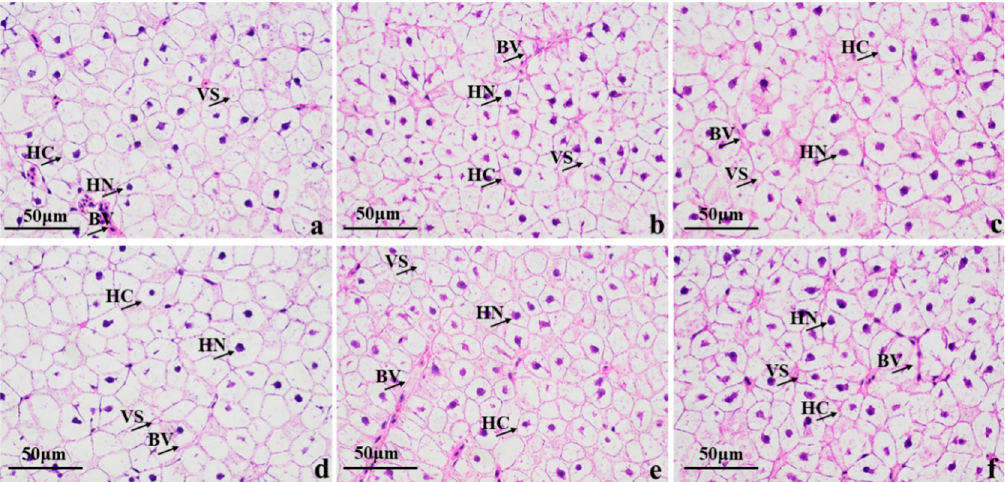
Figure 6. H&E-stained crucian carp liver tissue sections of ( a ) control group; ( b – f ) vanillin treat- ments at 0.50, 0.75, 1.00, 1.25, and 1.50 mg/L, respectively. Note: VS: vacuoles; HC: Hepatocytes; HN: Hepatocyte nucleus; BV: blood vessels.